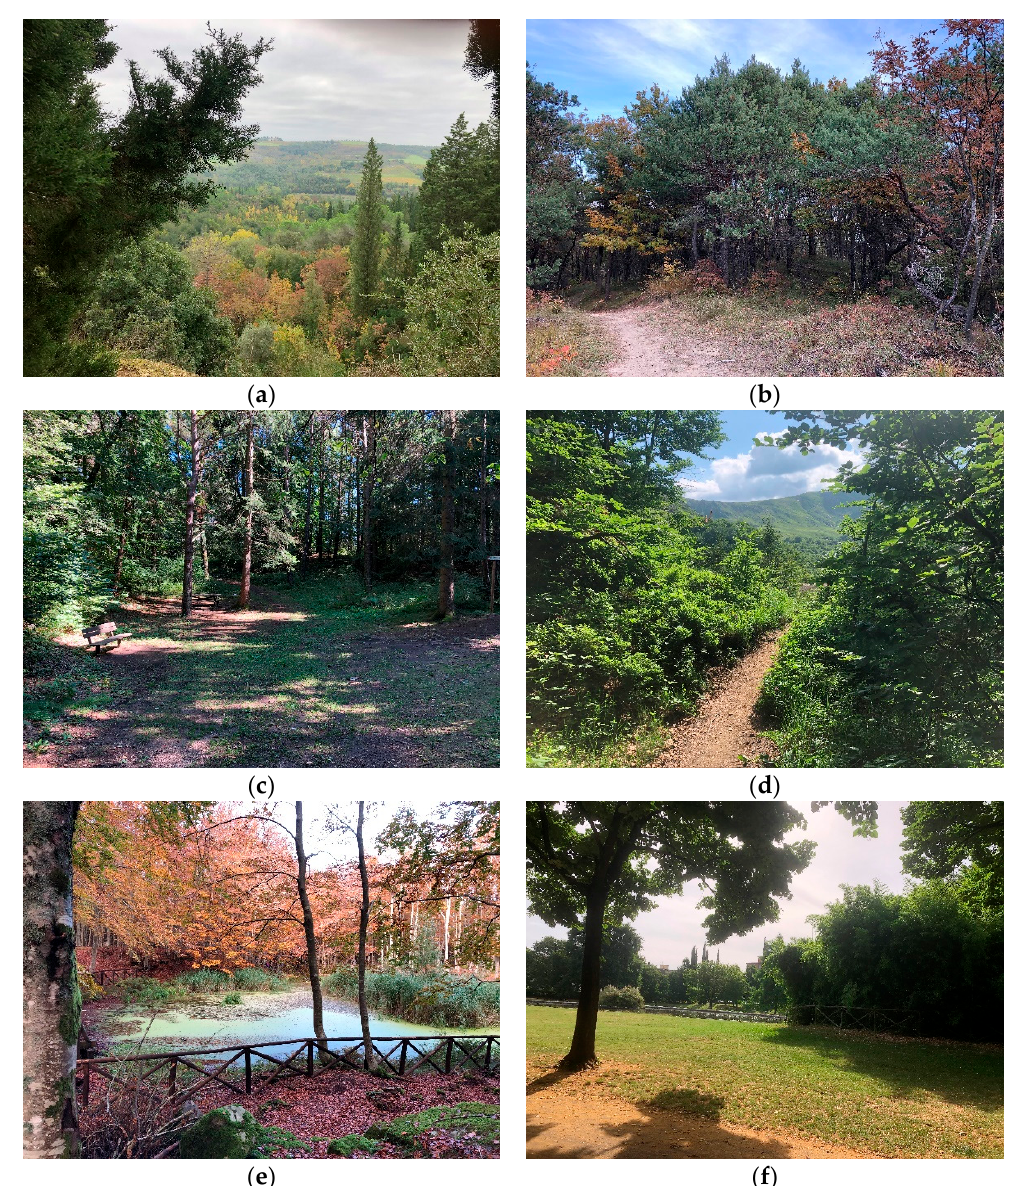
Figure 2a–f shows representative pictures of forest therapy sites.